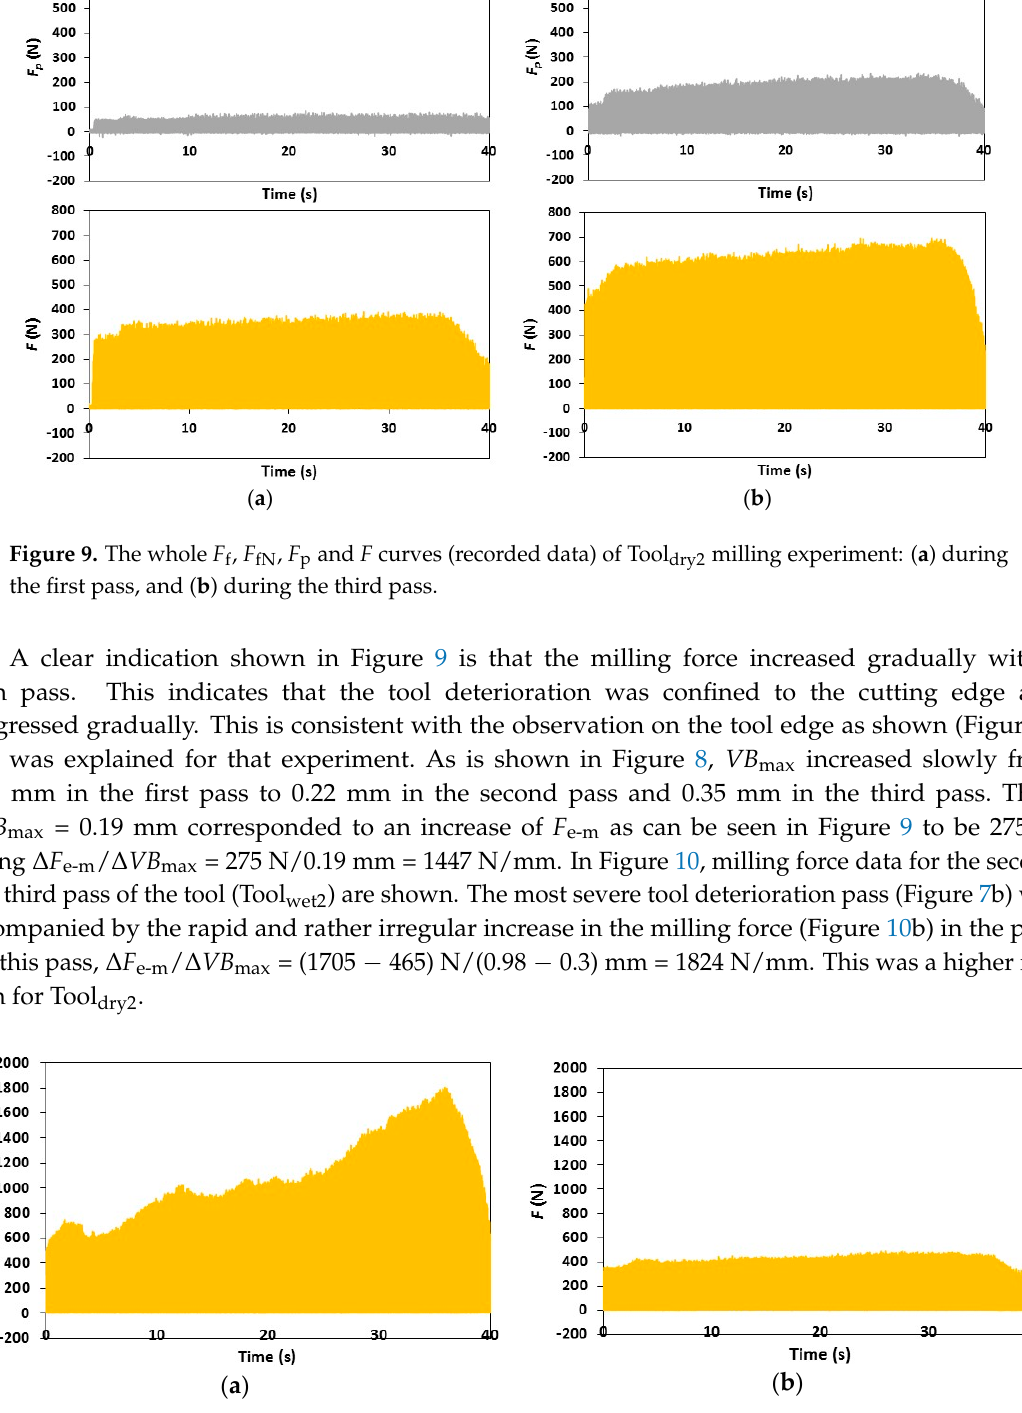
Figure 10. F curves (recorded data) of Tool wet2 milling experiment during ( a ) the second pass, and ( b ) the third pass.